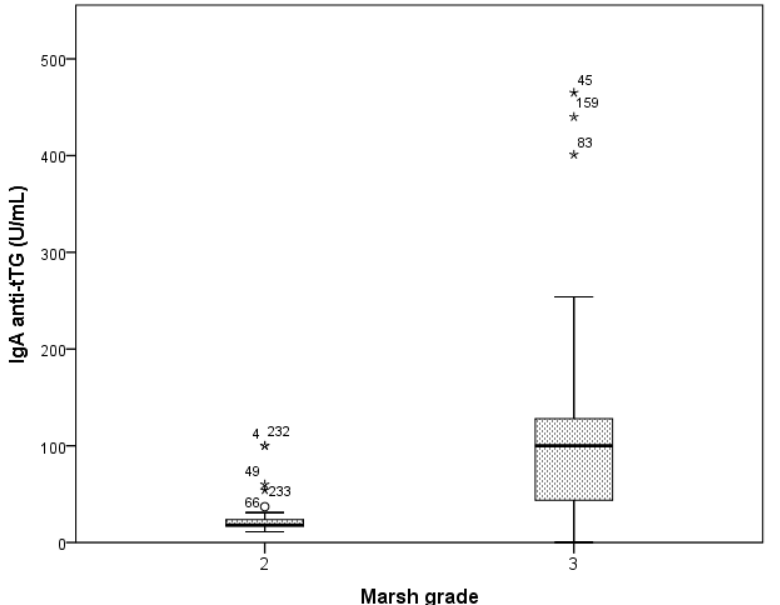
Figure 1. Flow-chart of the selection of patients enrolled in the study.